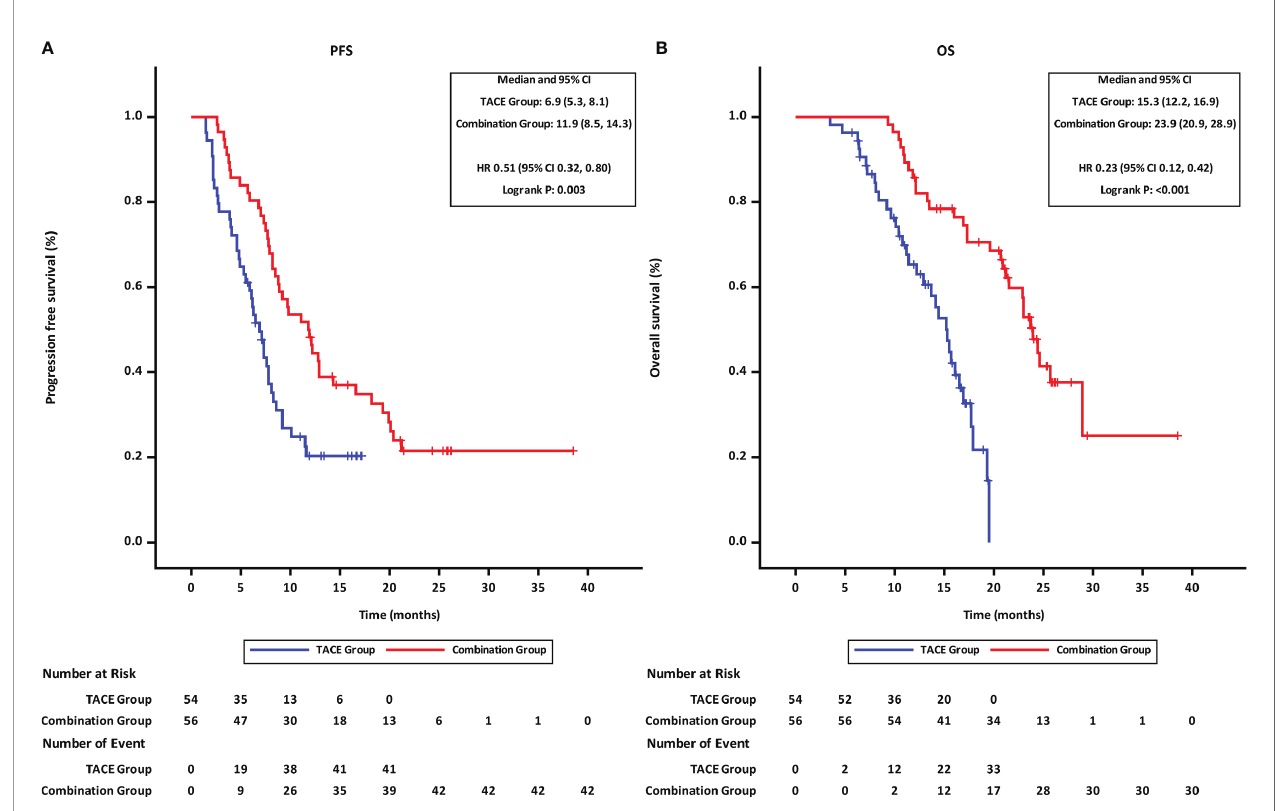
FIGURE 2 | Progression-free and overall survival of patients receiving the different treatments. (A) progression-free survival. (B) overall survival. TACE, transcatheter arterial chemoembolization; PD-1, programmed cell death-1; HR, hazard ratio; CI, con fi dence